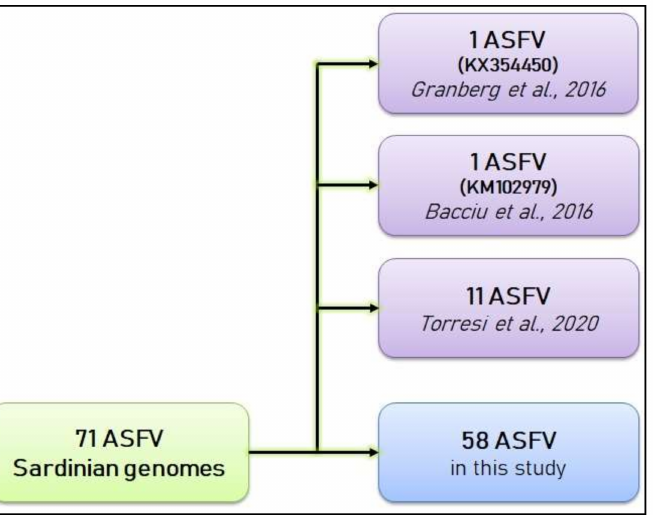
Figure 3. ASFV genome inclusion process flowchart. In total, 13 of the 71 genomes were derived from previous studies (Granberg et al., 2016; Bacciu et al., 2016; Torresi et al., 2020), and 58 are new genomes analyzed in this